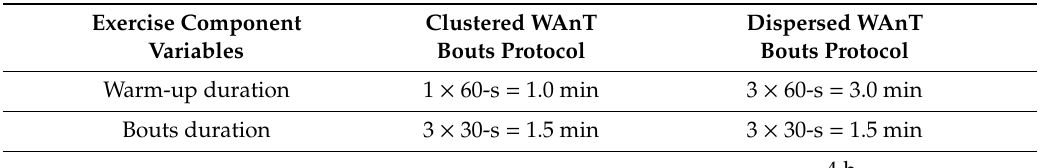
Table 1. Comparison of time commitment to perform a clustered vs. dispersed Wingate Anaerobic test (WAnT) cycle exercise training